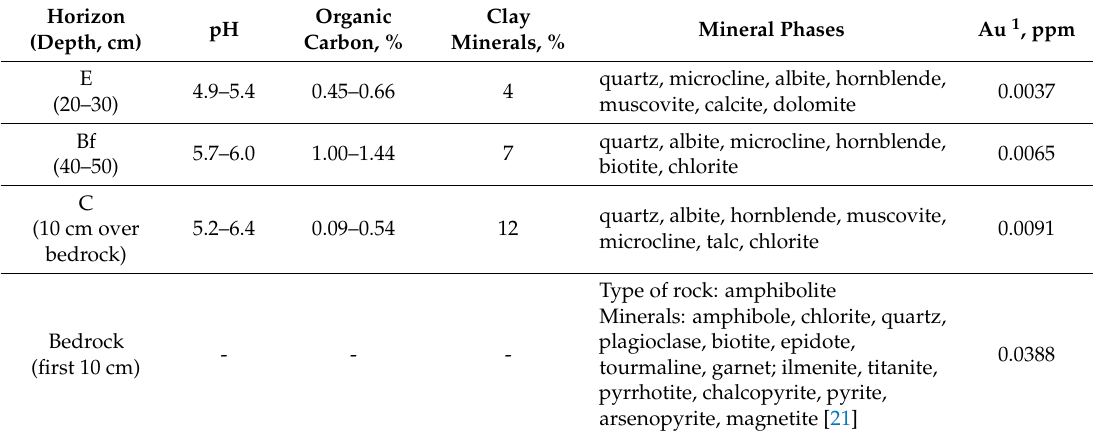
Table 1. The main chemical and mineralogical overburden and bedrock properties at Novye